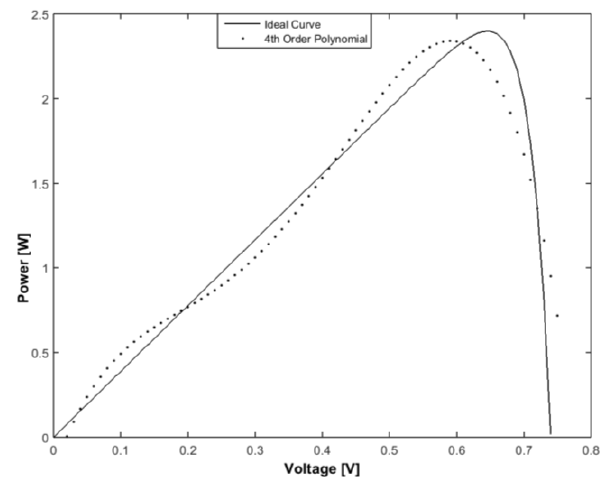
Figure 12 . P-V curve with 4th order polynomial fitting. The above figure shows the power-voltage curve for fourth order polynomial fitting. There are two figures we can see here one is the smoother which is P-V curve with ideal data and another is P-V curve with fitted data. The fourth order polynomial fitting method is considered here in order to fit the curve.